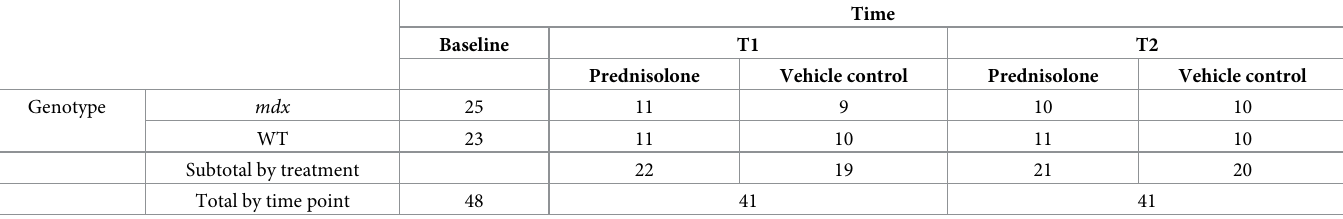
Table 1. The number of mice in each category, split by genotype, time point, and treatment. Note that no treatment was given at